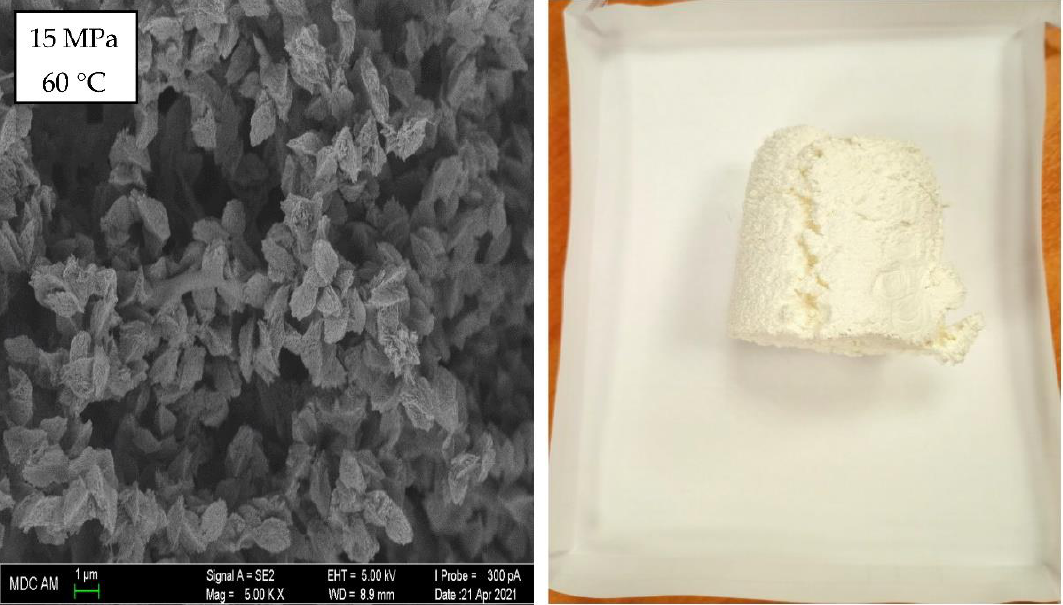
Figure 5. SEM image (phase morphology, left ) of the polymer blend microparticles with a compo- sition of PP-01030 (75%)/EPTSR-50 (25%) and photo ( right ) produced by SEDS at a temperature of t = 60 °C and pressure Р = 15 MPa (see Table 3, operating condition No. 6).